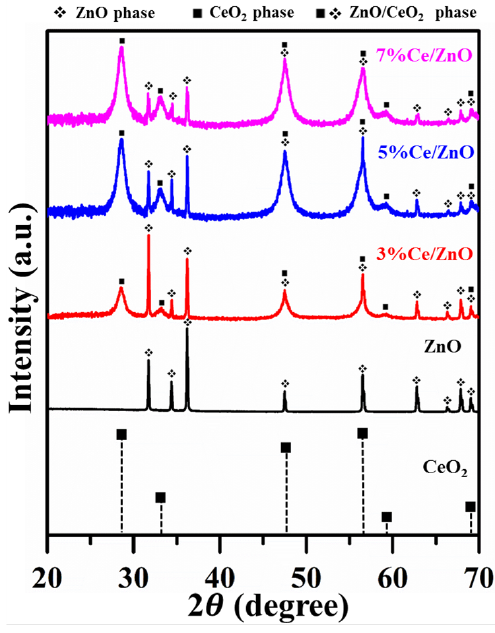
Figure 1. X-ray diffraction patterns of pristine ZnO, CeO 2 [37], and as-synthesized Ce/ZnO samples. Table 1. Lattice parameters, crystalline sizes, average particle sizes, and optical energy band